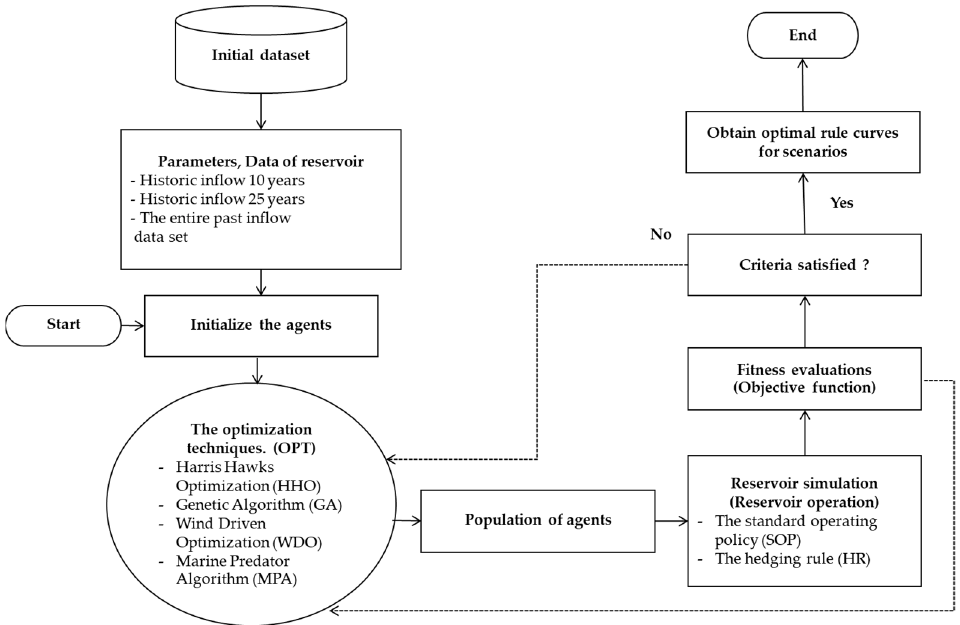
Figure 12. The model based within the network reservoir simulation model.